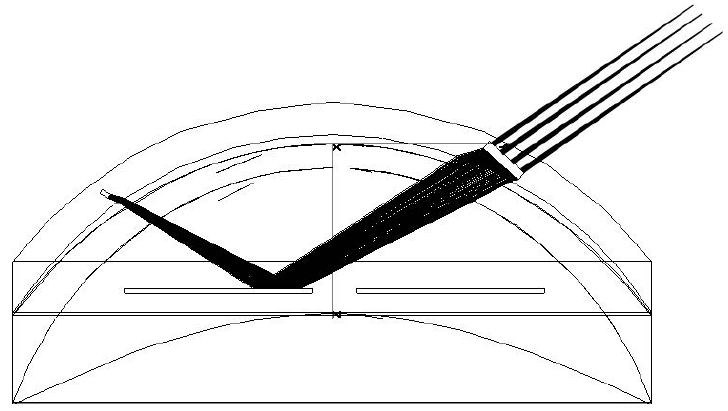
Figure 5. Example of the DOE mode of use when the sensor is outside the lens. Here, four micro-lenses form one to four focal spots, depending on the size of the pupil and thus of the iris surface illuminated.